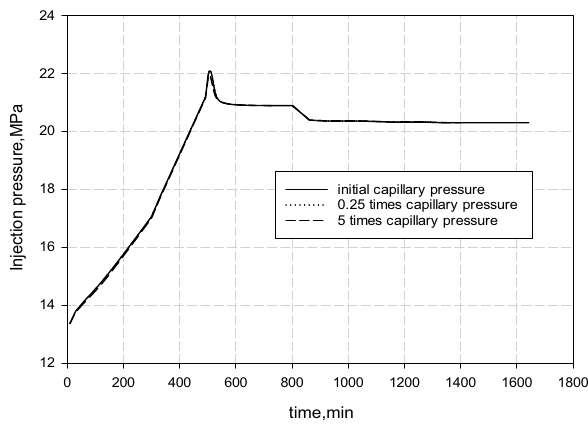
Fig. 10 Injection pressure curve under different capillary pressures